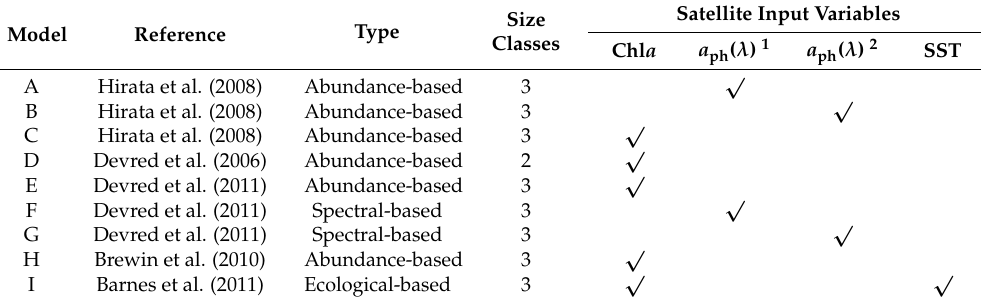
Table 2. Description of models used in this study.